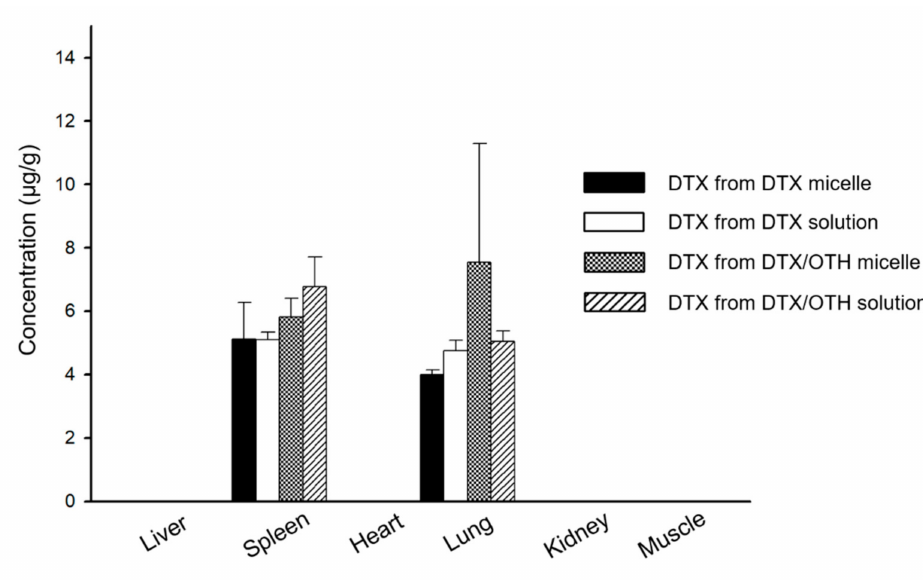
Figure 6. Biodistribution of docetaxel (DTX) in single and combined formulations, at 8 h after intravenous injection, in each